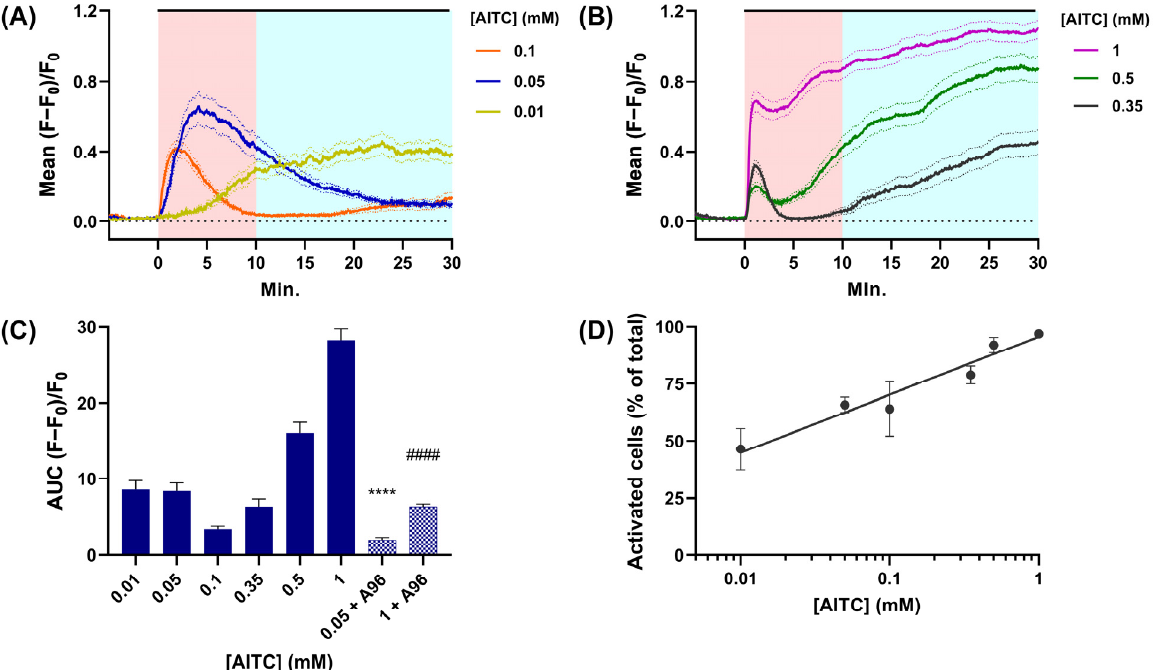
Figure 2. AITC elicits bi-phasic increases in [Ca 2+ ] i with a complex relationship to agonist concen- tration. Cultured TGNs were loaded with Fluo-4 AM and fluorescence intensity was recorded by time-lapse confocal microscopy. ( A , B ) Solid lines indicate the mean increases of fluorescence intensity (F − F 0 ) evoked by various [AITC] relative to initial fluorescence (F 0 ), plotted against time. Dotted lines above and below the solid traces indicate ± s.e.m. The black lines above the traces indicate the period AITC was present. ( C ) Area under the curve (AUC) of mean fluorescence change recorded over 30 min for each [AITC] in the absence (N = 3, n ≥ 100) or presence of 100 µ M A967079 [(A96), N = 2, n ≥ 30]; data were analysed using unpaired t -test with Welch’s correction; **** p ≤ 0.0001, 0.05 mM AITC vs. 0.05 mM AITC + A967079; #### p ≤ 0.0001 1 mM AITC vs. 1 mM AITC + A967079. Error bars represent standard error. ( D ) The % of excitable cells ( ± s.e.m.; N = 3, n ≥ 80) that responded to different concentrations of AITC.